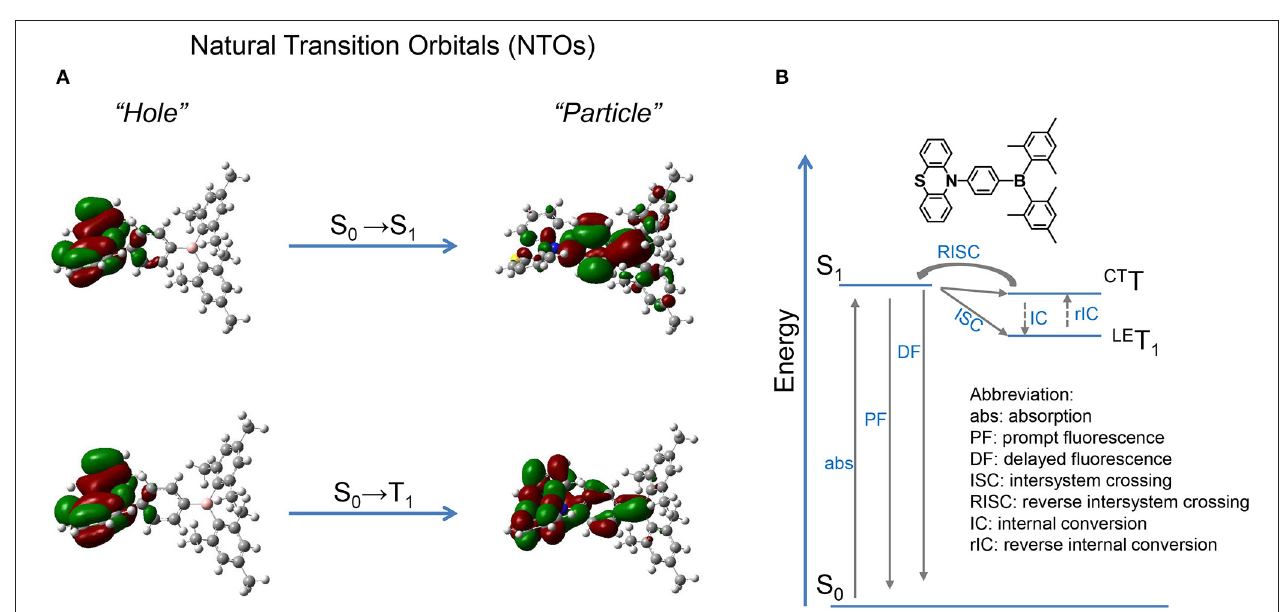
Frontiers in Chemistry |